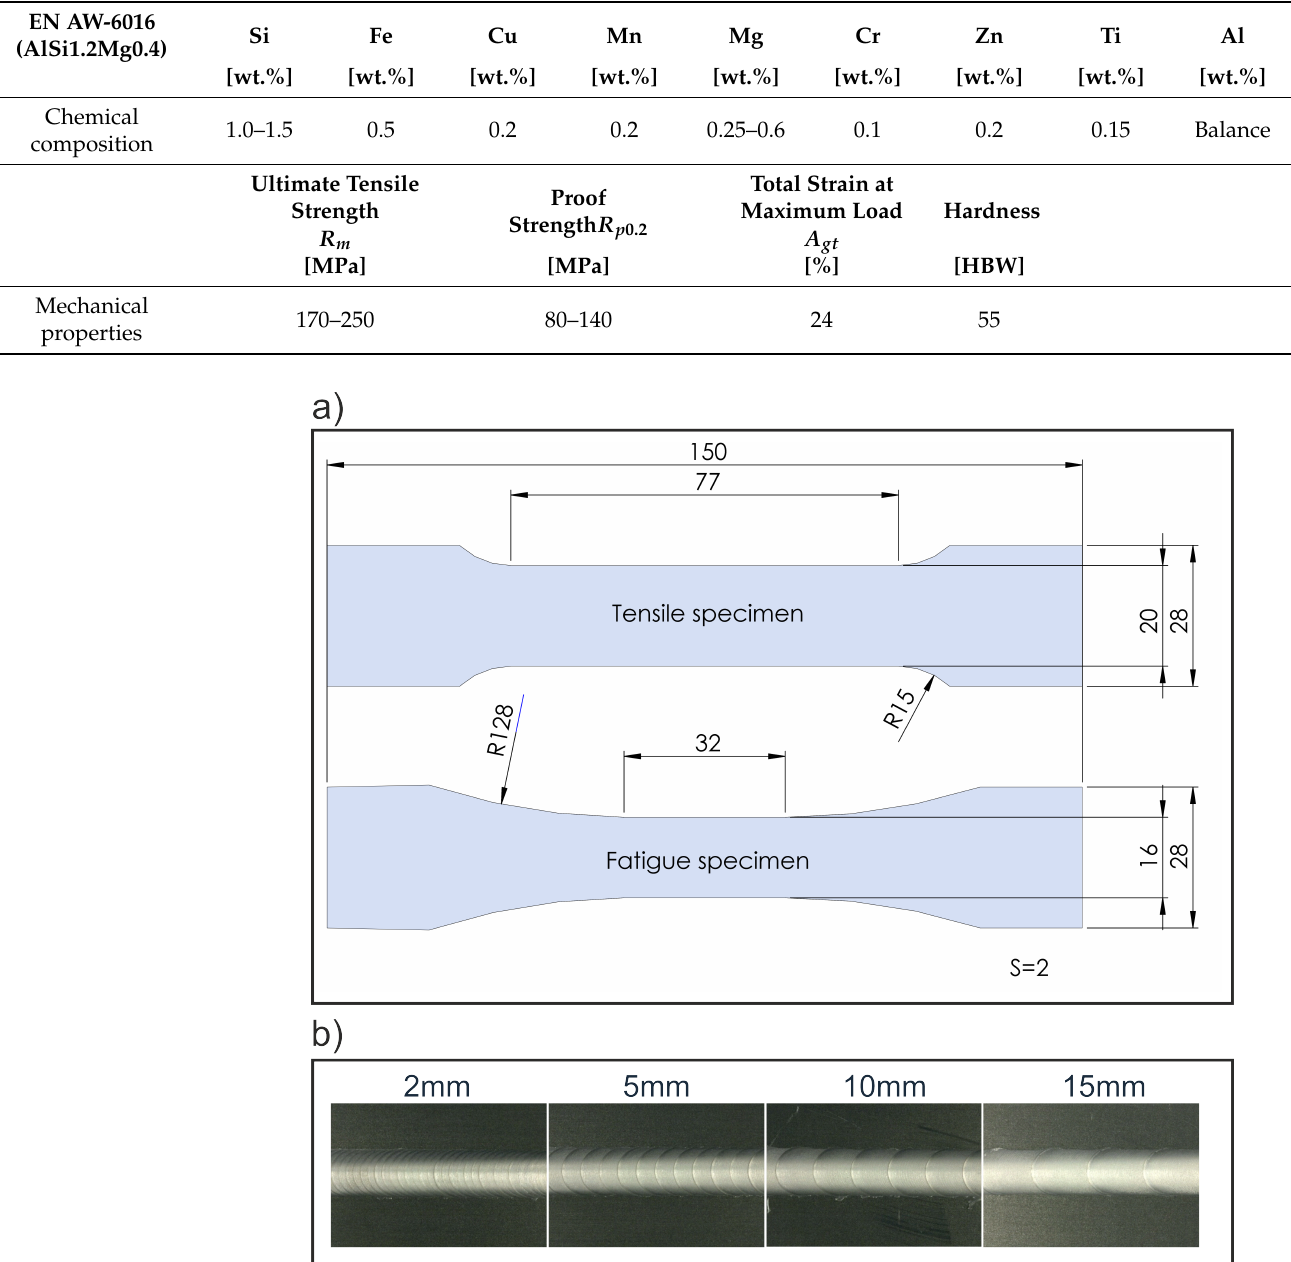
Figure 3. ( a ) Specimen geometry for tensile and fatigue testing according to DIN EN ISO 6892-1 and ASTM E466-15 [28,29] with all dimensions in millimeter.; ( b ) welded intersecting friction stitch welds with weld lengths between 2 mm and 15